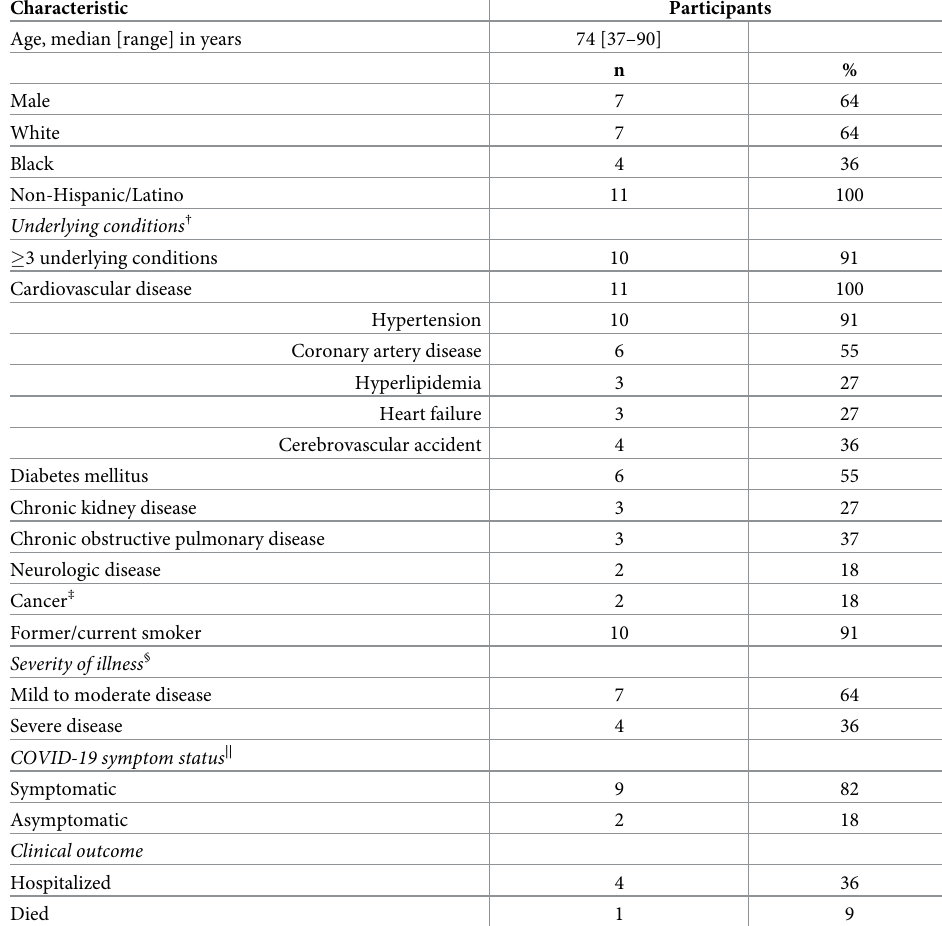
Table 1. Demographic and clinical characteristics of participants � (N = 11) in a nursing home cohort—Georgia, October 2020–April 2021.